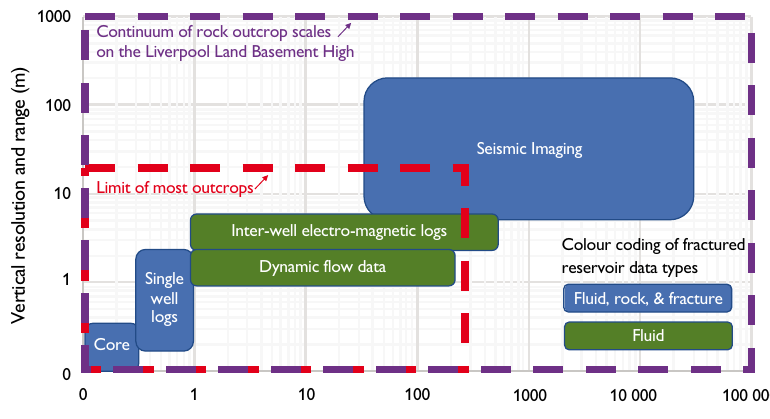
Fig. 3. Spatial scales of input data for fractured reservoir models. Geological outcrops are often limited to the scales indicated by the red dashed line. LLBH encompasses the full range of scales required to cover all fractured reservoir para- meters (purple dashed